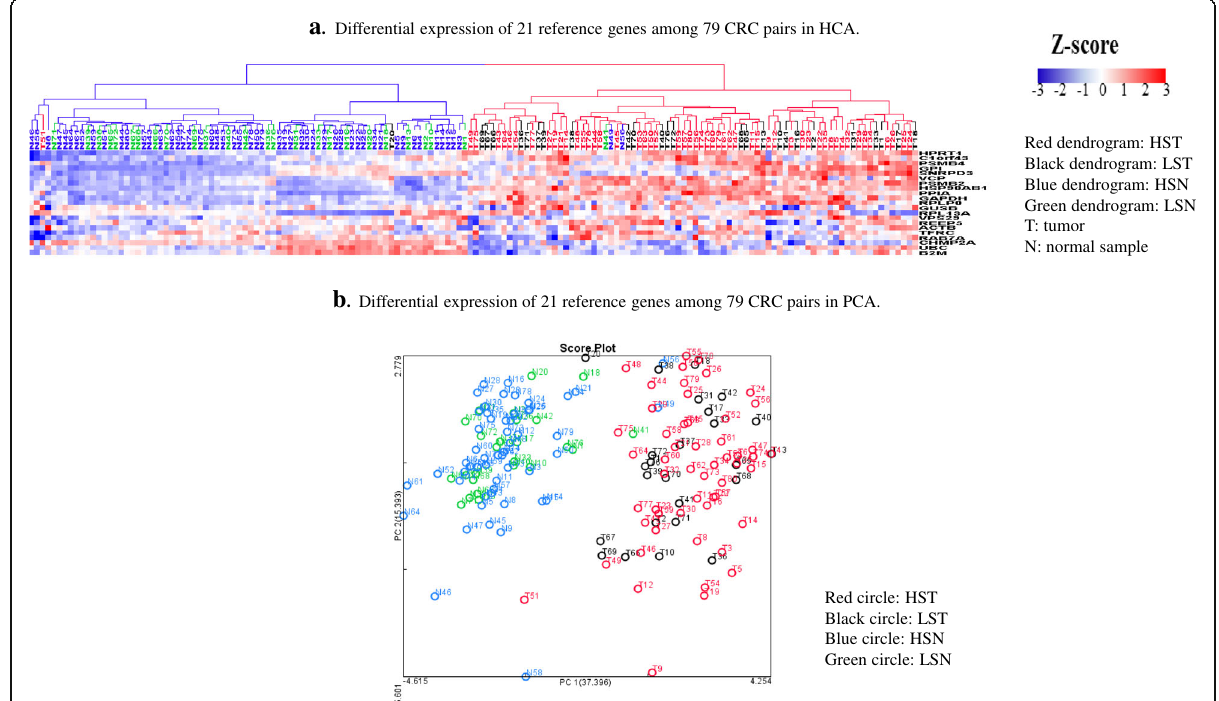
Fig. 2 HCA and PCA analysis of 21 classical reference genes in 79 CRC pairs. a . Differential expression of 21 reference genes among 79 CRC pairs in HCA. b . Differential expression of 21 reference genes among 79 CRC pairs in